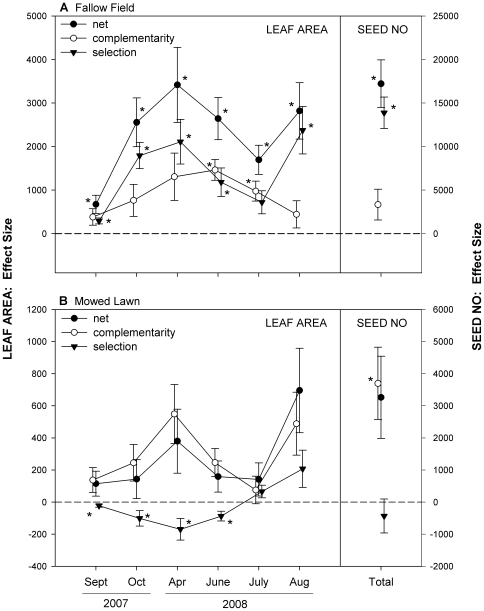
Partitioning of net biodiversity effects.Mean net biodiversity (•), complementarity (○) and selection effects (▾) ±1 SE for plant leaf area (cm2) over time and cumulative seed number (2007–2008) (N = 55). Means are shown separately for (a) the fallow field and (b) the mowed lawn. The dashed line indicates an effect size of zero. A star (*) indicates that the mean is significantly different from zero (p<0.05, t-tests where data were normal or could be transformed, sign-tests for remaining cases: see text for details).